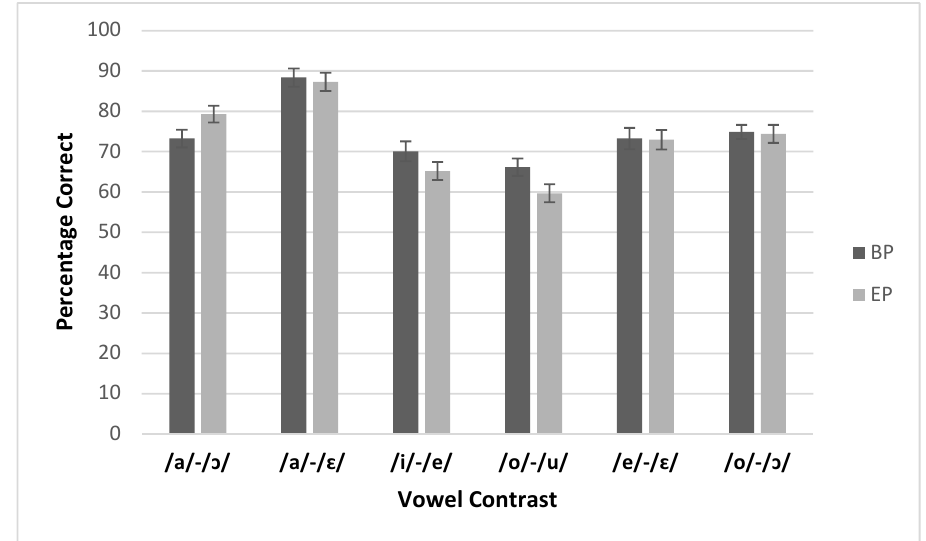
Figure 2. Percentage correct across the BP and EP contrasts for all participants pooled together.